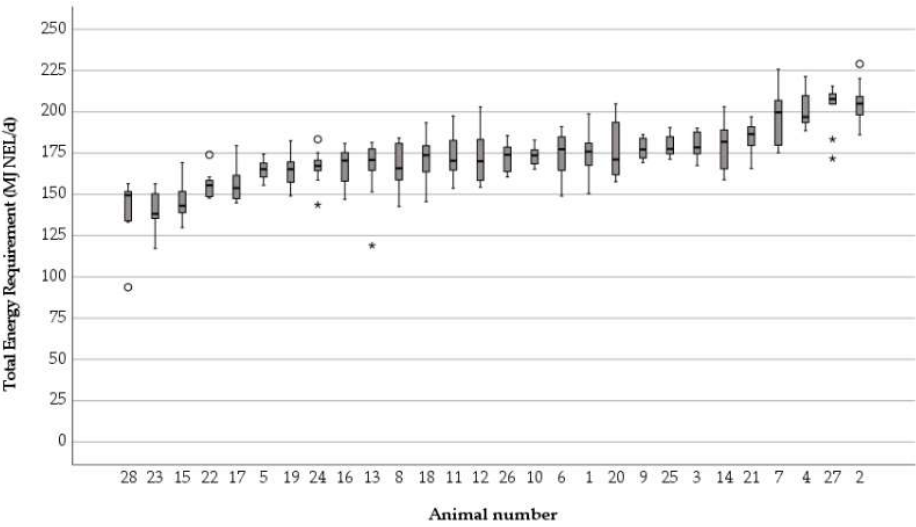
Figure 7. Total energy requirement (MJ NEL/d) calculated between weeks 2 and 15 postpartum (p.p.). In each subfigure, the boxplots respectively highlight the median, upper, and lower quartiles of each week. Box whiskers extended to the most extreme nonoutlier data points were considered as outliers if they lie more than 1.5 times the interquartile range from the edge of the box. Small circles = outliers (1.5 × interquartile range (IQR)); asterisks = extreme values (3 × IQR).